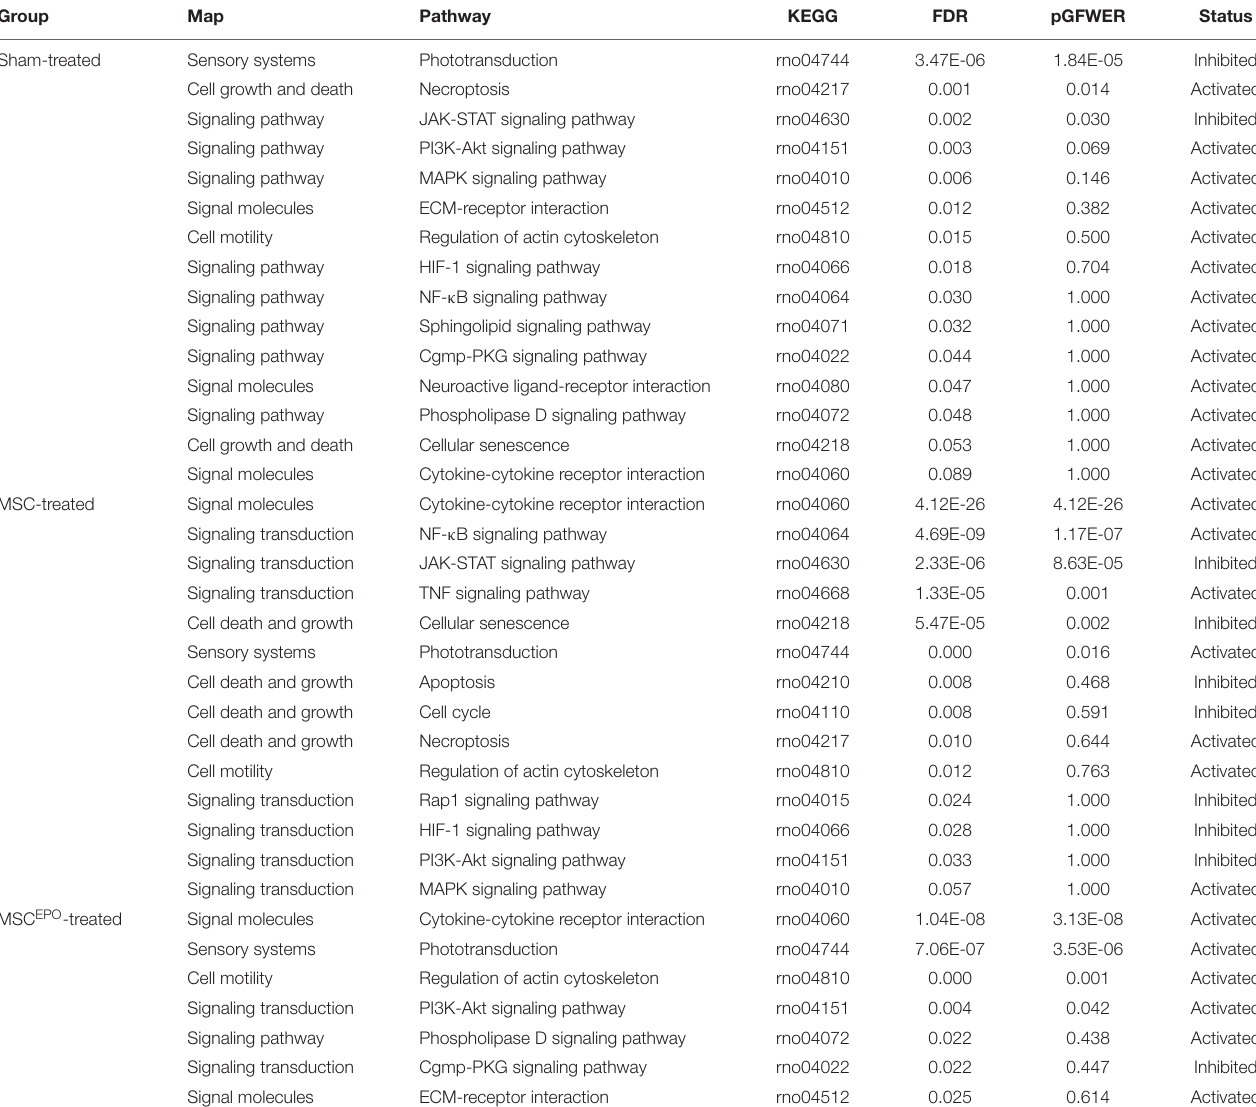
TABLE 3 | After performing a pathway topology analysis with SPIA, significant KEGG pathways in sensory systems and environmental information processing were tabulated. KEGG, Kyoto Encyclopedia of Genes and Genomes; FDR, false discovery rate; pGFWER, Bonferroni adjusted global p-values. Group Map Pathway KEGG FDR pGFWER